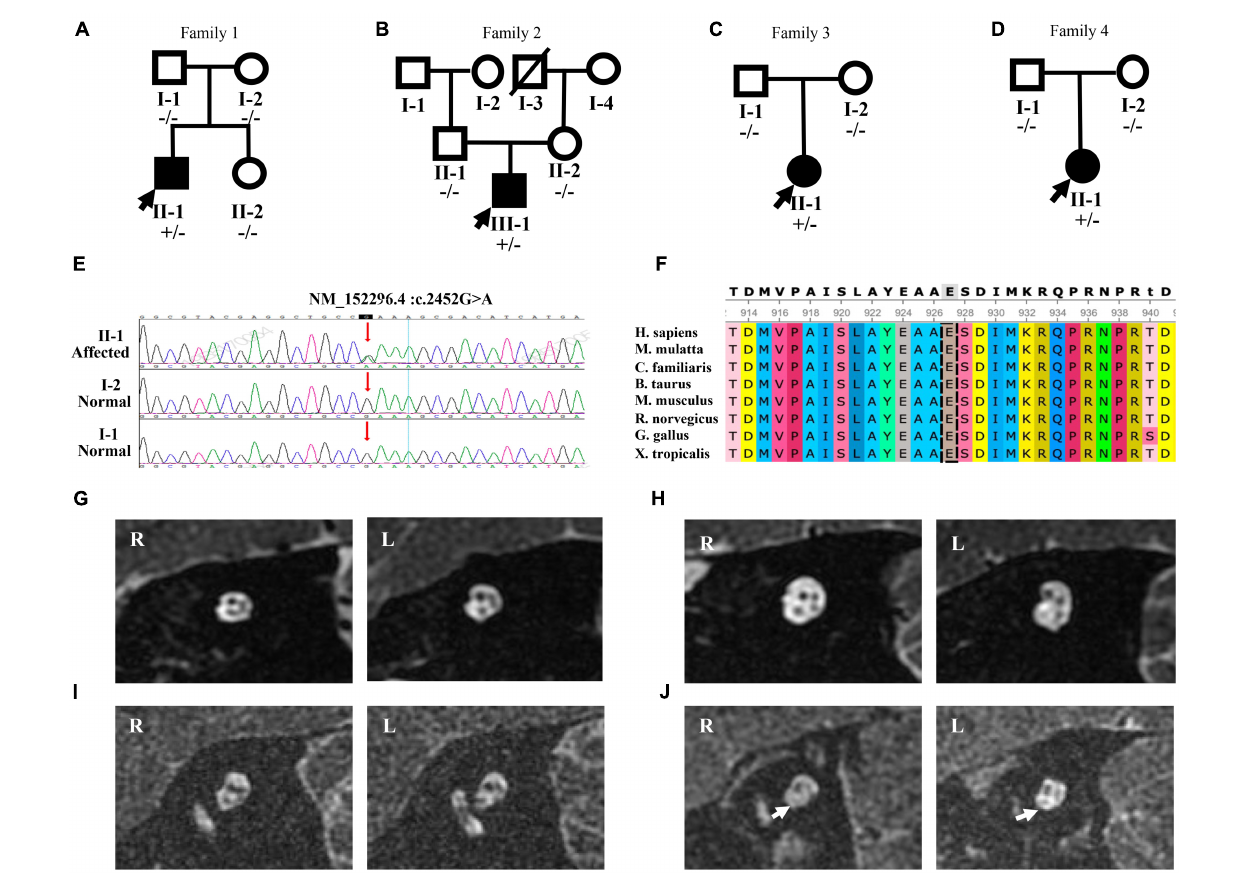
FIGURE 2 | Mutation analysis and MRI results of four patients with the p.E818K mutation. (A–C) , and (D) Pedigree of four families. Filled symbols denote affected individuals, whereas unfilled symbols denote the unaffected. A slash (/) indicates a deceased person. Minus sign (-/-) represents homozygosity for the wild-type allele, and plus-minus sign ( ± ) represents heterozygosity for the mutant allele. Probands are indicated by arrows. (E) Sanger sequencing chromatograms of four pedigrees confirmed that all four subjects shared one common heterozygous mutation, c.2452 G > A (arrow) leading to p.E818K amino acid change, whereas their parents are normal. (F) Protein conservation of no. 818 amino acid among vertebrate species ( H. sapiens , M. mulatta , C. familiaris , B. taurus , M. musculus , R. norvegicus , G. gallus , and X. tropicalis ). No. 818 amino acid is highly conserved. (G–I) , and (J) MRI results showing bilateral internal auditory canals (IACs) of patients 1, 2, 3, and 4, respectively. The oblique-sagittal image through the bilateral IACs of patient 4 (J) demonstrates absent bilateral cochlear nerves (white